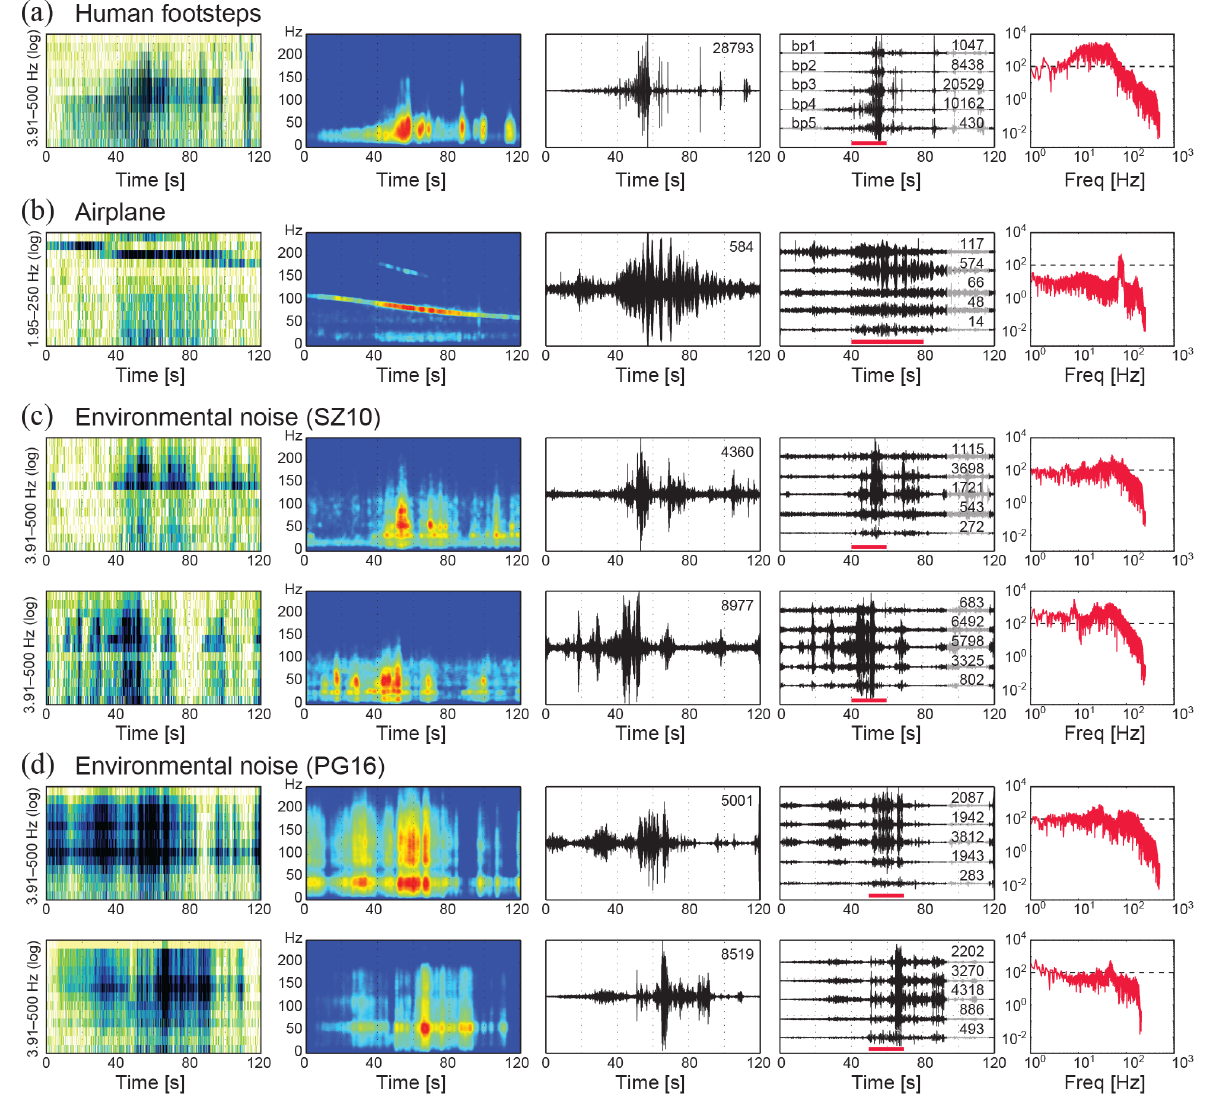
Figure 9. Seismic features of the most common external sources of tremor-like radiations. (a) Human footsteps at short distance at SZ10, S1.2, t 0 5 June 2010, 13:08:33. (b) Airplane at PG16, S2.1, t 0 8 November 2016, 04:56:00 with typical gliding harmonics in the spectrogram. (c) Environmental noise recorded at SZ10, stations S2.3 (top) and S3.8 (bottom) at t 0 9 June 2010, 22:54:10 and (d) at PG16, stations S2.1 (top) and S3.1 (bottom) at t 0 8 November 2016,